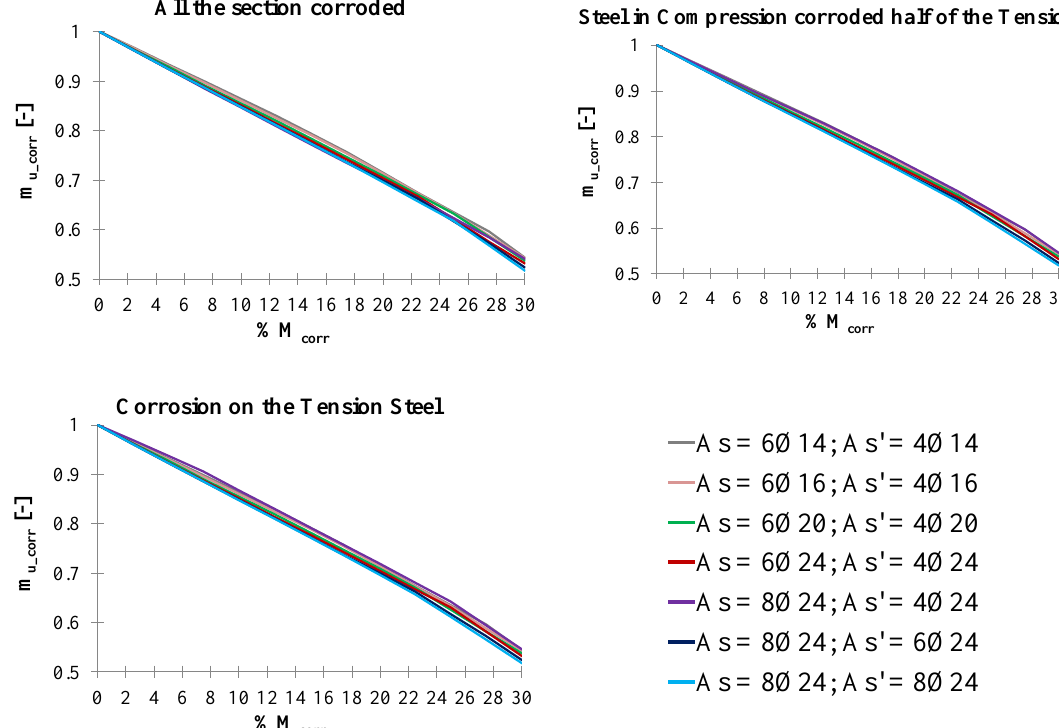
Figure 9. Nondimensional ultimate bending moment for different corrosion scenarios — flat beam, pitting corrosion.